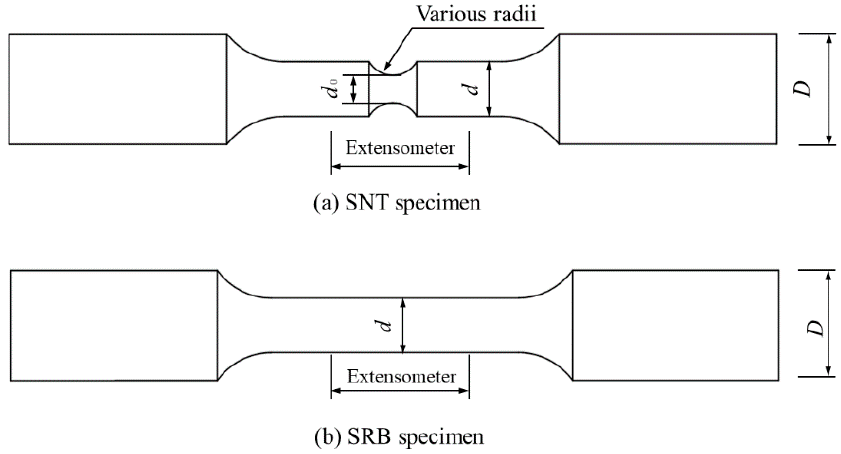
Figure 1. The geometry of specimens.